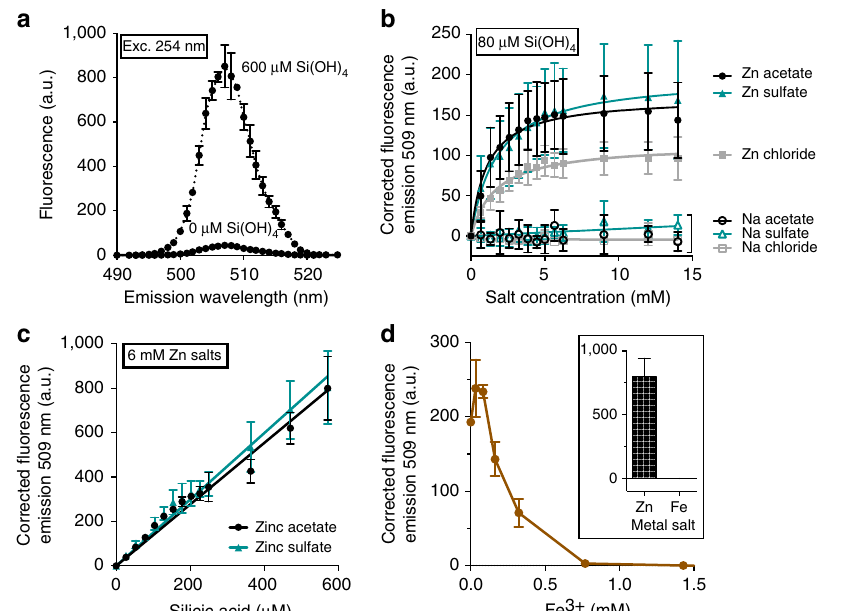
Figure 3 | Silicic acid augments the fluorescence of Zn salts in Tris/KCl buffer. ( a ) Fluorescence emission of 6mM Zn acetate solutions increases 20-fold in 600 m M silicic acid. ( b ) The emission signal saturates at approximately 60-fold molar excess of Zn salt. ( c ) When Zn salts are held in excess, silicic acid titration produces a linear response. ( d ) Competition with Fe 3 þ yields non-fluorescent Fe complexes. Inset, fluorescence of Zn and Fe complexes at 600 m M silicic acid. All data are mean ± s.d., n ¼